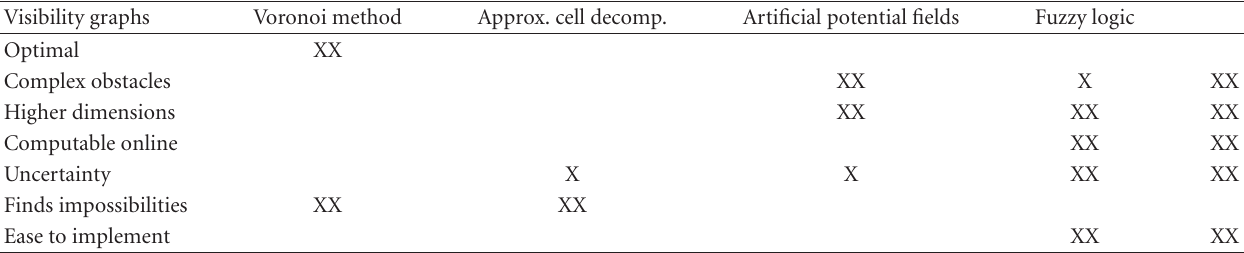
Table 1: Advantages and disadvantages of several, common path planning